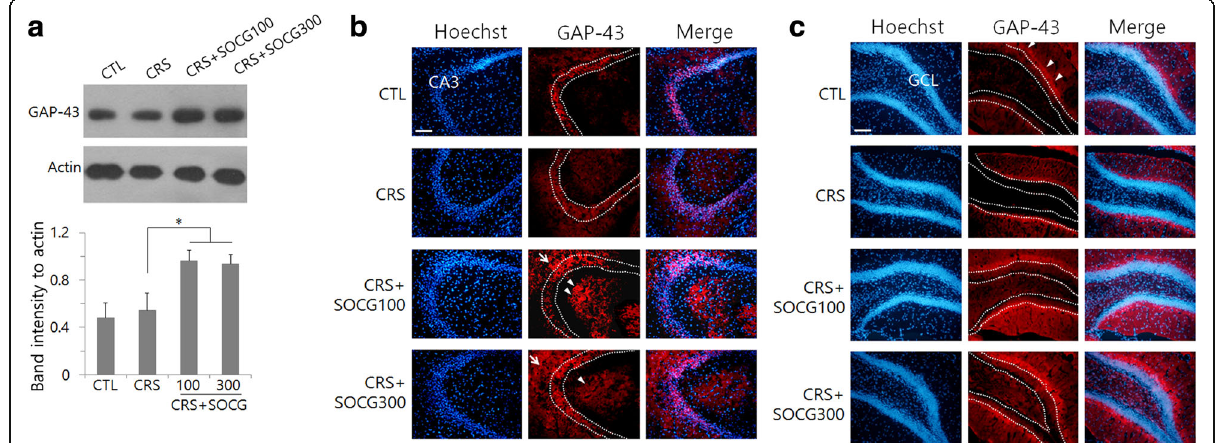
Fig. 4 Regulation of GAP-43 levels in the hippocampus by SOCG treatment in CRS animals. a Western blot analysis of GAP-43 in the hippocampal tissue. Images in the upper panel show the representatives from 4 independent experiments, and quantitation of protein band intensity relative to actin control are shown in the lower panel. * P < 0.05. (One-way ANOVA, n = 4). b Immunohistochemical analysis of GAP-43 in the CA3 region. GAP-43 signals were seen in the striatum oriens (arrows) and striatum radiatum (arrowheads) besides CA3 pyramidal cell layer. c GAP-43 signals in the dentate gyrus. GAP-43 signals were observed clearly in the inner molecular layer (arrowheads), but rarely seen from the granule cell layer (GCL). Scale bars in ( b ) and ( c ): 200 μ m